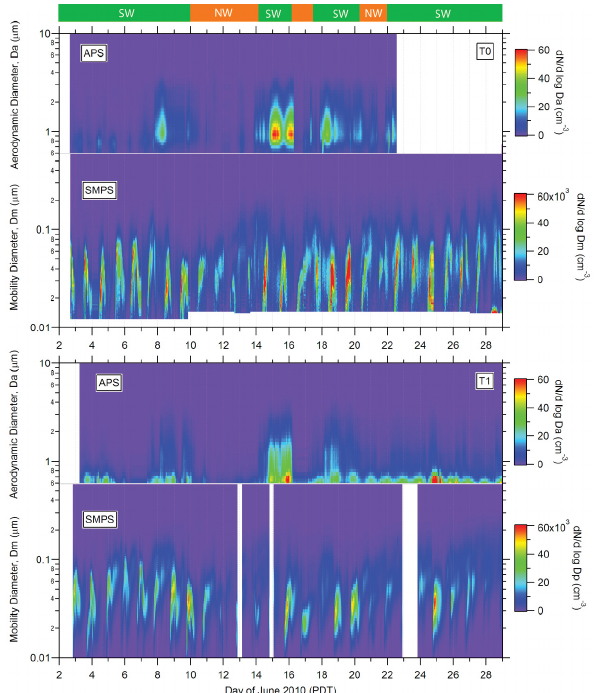
Fig. 11. Comparison of aerosol number size distributions at T0 and T1 sites. Note that the color scales for APS and SMPS distributions differ by three orders of